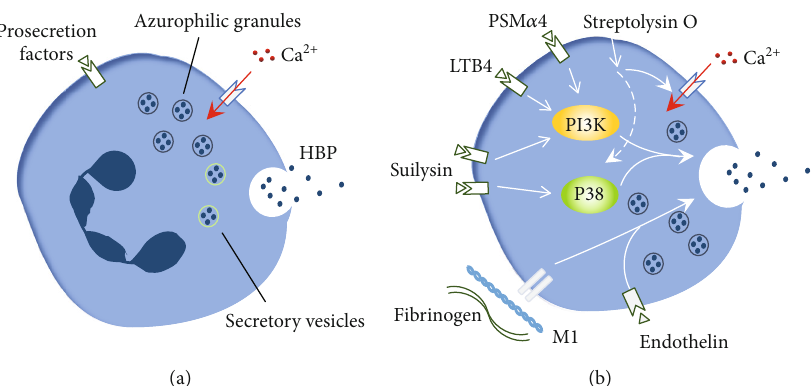
Figure 1: The complex mechanisms underlying HBP release. (a) Prosecretion factors stimulate PMNs to release HBP following an in fl ux of Ca 2+ . (b) The speci fi c signaling pathways of di ff erent factors responsible for activating PMNs, including PSM α 4/LTB4/suilysin-receptor- PI3K, suilysin-GPCR-P38, fi brinogen-M1- β integrin, streptolysin O-P38/Ca 2+ in fl ux, and endothelin-ET